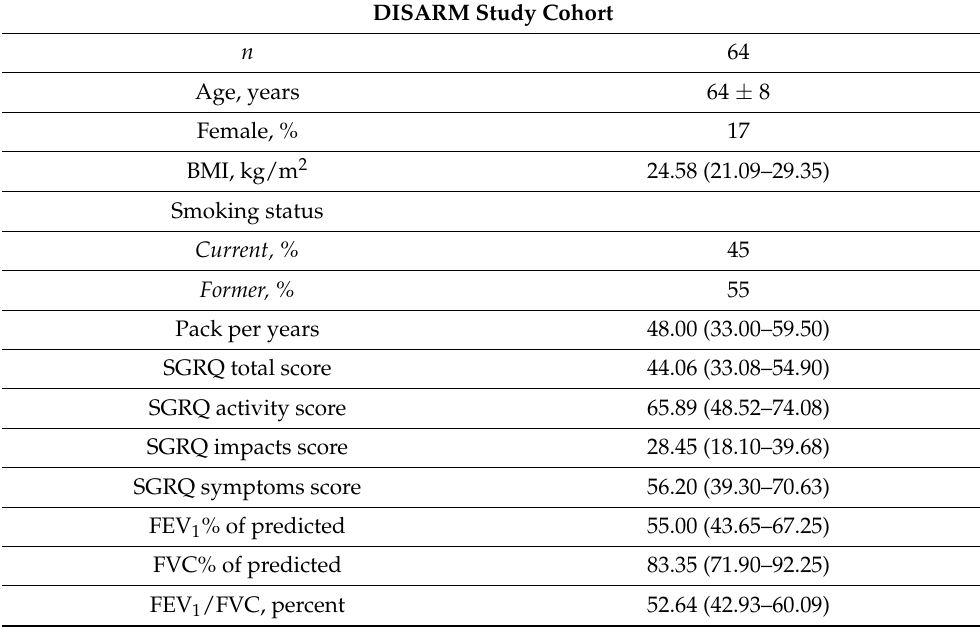
Table 1. Demographic characteristics at